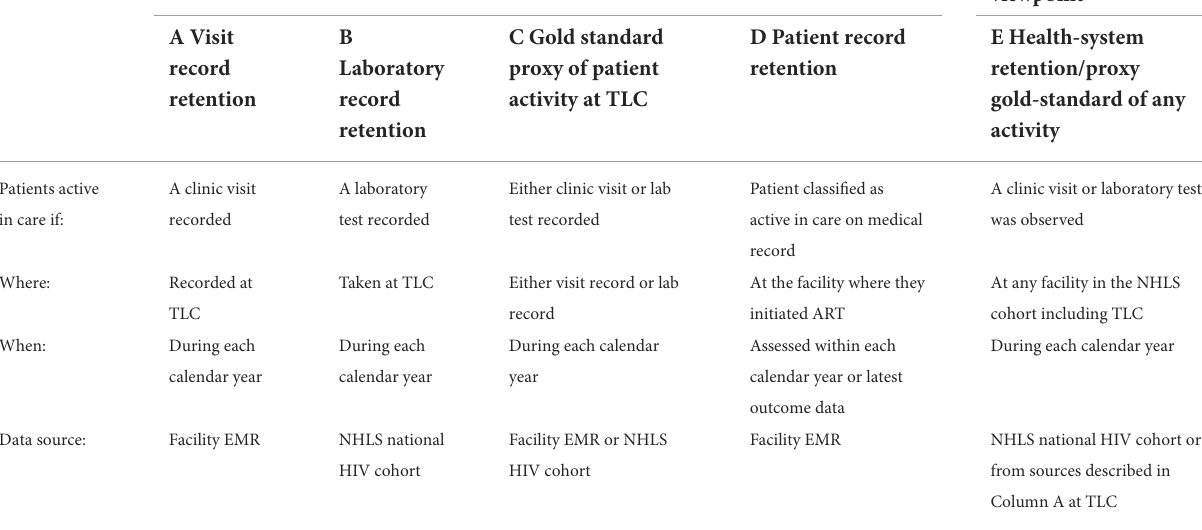
TABLE 1 Description of study outcome